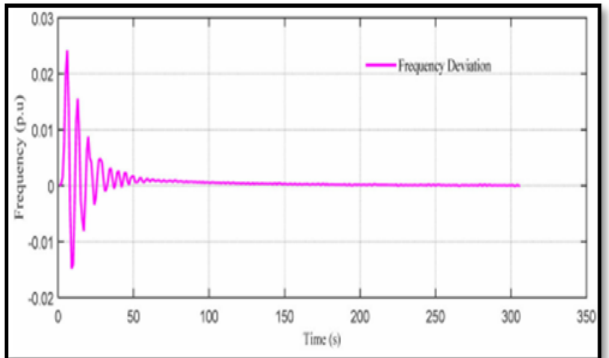
Figure 3. Responses of the frequency deviation with BES in area 1